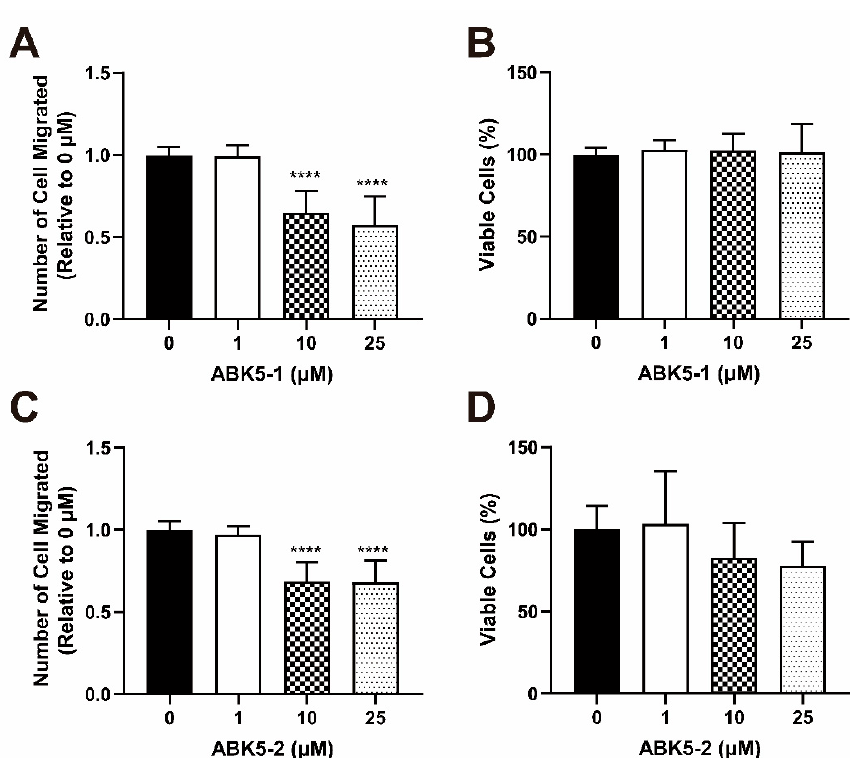
Figure 5. Effect of ABK5-1 and ABK5-2 on CXCL12-mediated Jurkat cell migration. Transwell migration of Jurkat cells treated with ( A , B ) ABK5-1 or ( C , D ) ABK5-2. Frames ( A , C ): Cells were treated with vehicle or various concentrations of test compounds for 2 h and then allowed to migrate through transwells for 2 h. Cell numbers migrated to the lower chamber are indicated as relative to vehicle (DMSO) alone. Results are indicated as the mean ± S.D. of three independent assays performed in triplicate for each concentration. Viability of cells treated with ( B ) ABK5-1 or ( D ) ABK5-2 after the migration assay was also examined. Cells were treated exactly the same but without transwells and viability was determined. Results are indicated as the mean ± S.D. of three independent assays performed for each concentration. One-way ANOVA plus Dunnett’s post-hoc test were used for both migration and viability assays. **** p < 0.0001 (versus vehicle control group).